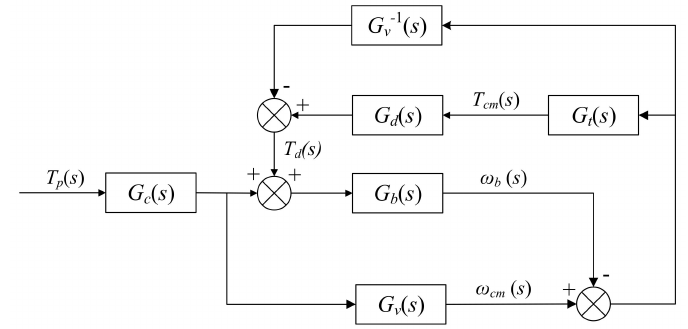
Figure 3. Process of the road load simulation (RLS) based on the forward